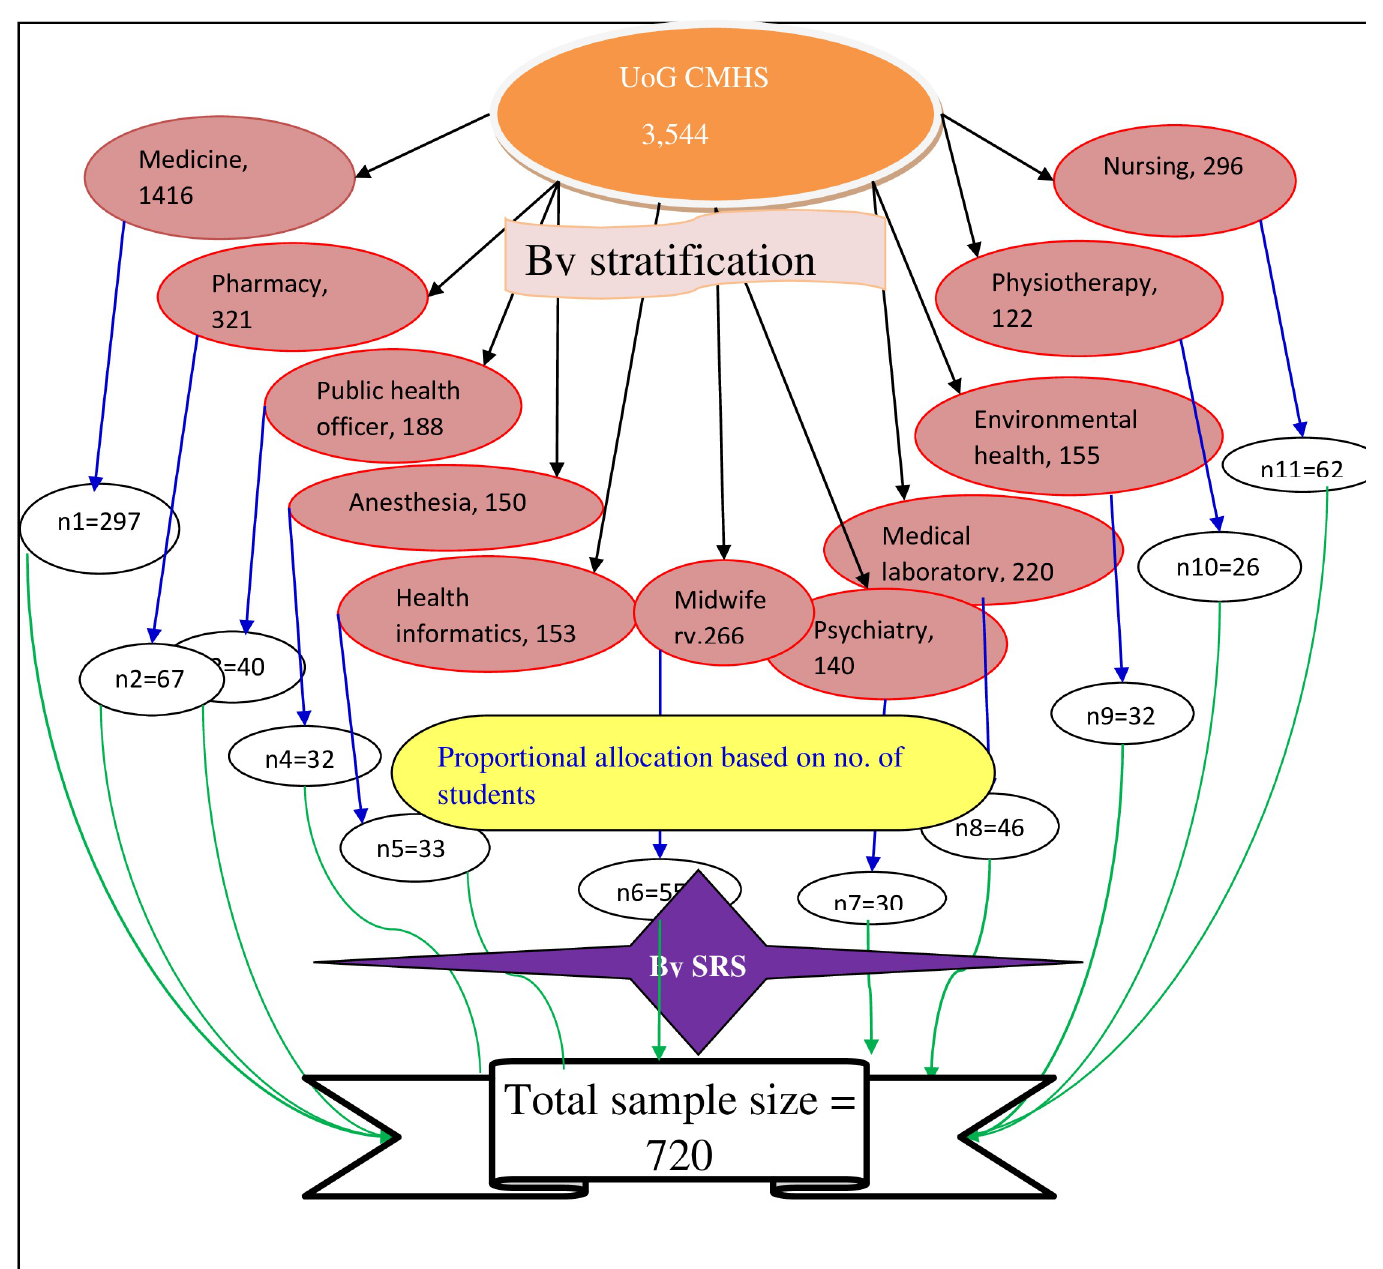
Fig 1. Sampling procedure for assessing visual impairment among medical and health science students at University of Gondar College of Medicine and Health Sciences.